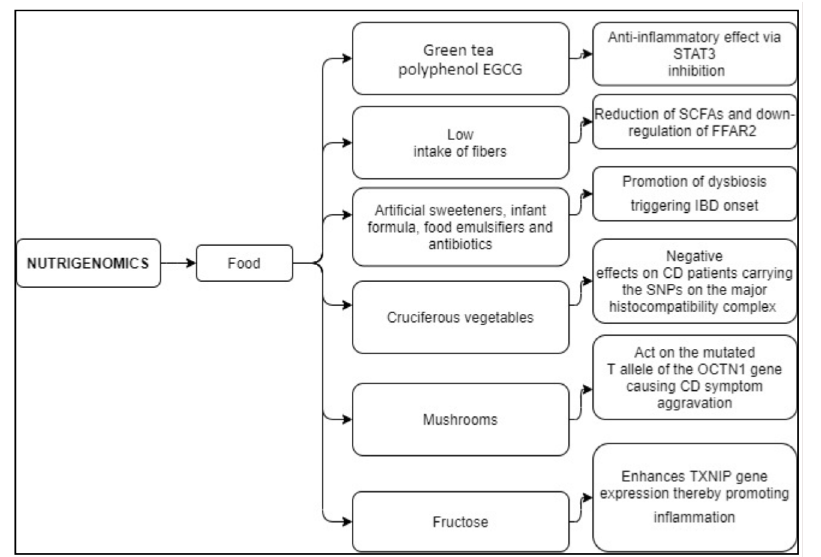
Figure 3. Nutrigenomics: effects of food on the modulation of gene expression and their influence on CD evolution. Abbreviations: EGCG, EpiGalloCatechin Gallate; STAT3, Signal Transducer and Activator of Transcription 3; SCFAs, Short-Chain Fatty Acids; FFAR2, Free Fatty Acid Receptor 2 gene; IBD, Inflammatory Bowel Disease; SNPs, Single-Nucleotide Polymorphism; OCTN1, Sodium- Dependent Organic Cation Transporter gene; TXNIP, Thioredoxin-Interacting Protein; NF- κ B, Nuclear Factor Kappa-Light-Chain-Enhancer of Activated B